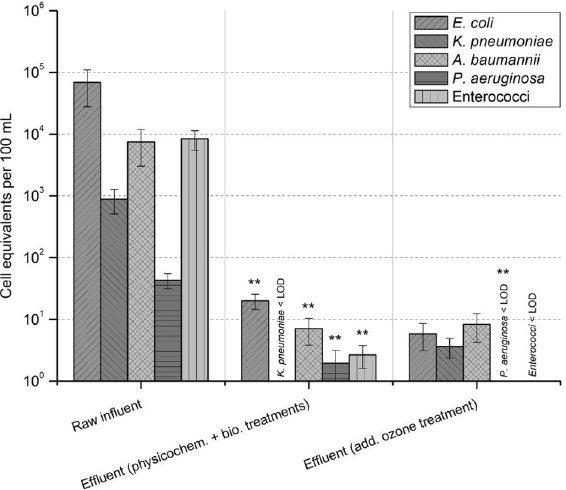
Figure 4. Abundance of facultative pathogenic bacteria in influent and effluent after physicochemical and biological treatments and subsequent ozone treatment. Displayed are mean values with standard deviation. Significance is given by one-tailed nonparametric Mann–Whitney U test calculation and is shown by asterisks (** p ≤ 0.001). Compared are gene copies per 100 mL in (i) raw influent with effluent after physicochemical and biological treatments and (ii) in effluent after physicochemical and biological treatments with effluent after subsequent ozone treatment. LOD – limit of detection.